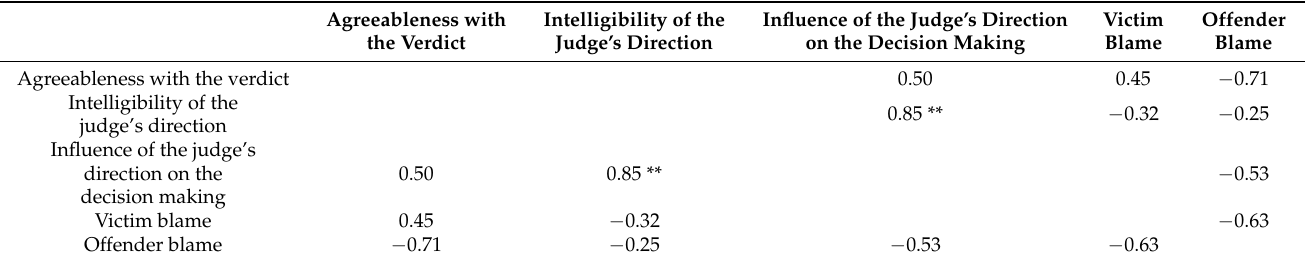
Table 2. Correlation between the variables for the intervention group.